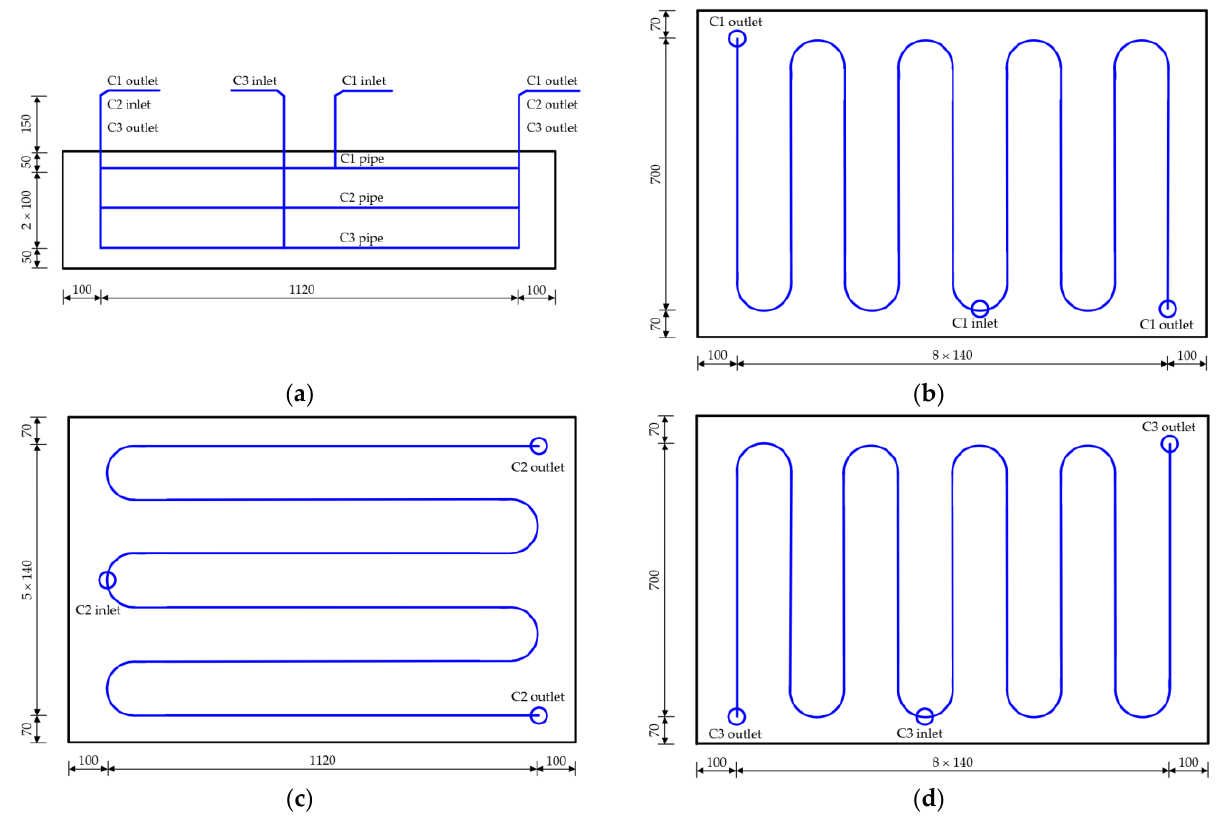
Figure 4. The cooling pipe layout of cushion cap: ( a ) elevation; ( b ) C1 pipe; ( c ) C2 pipe; ( d ) C3 pipe (unit: cm).